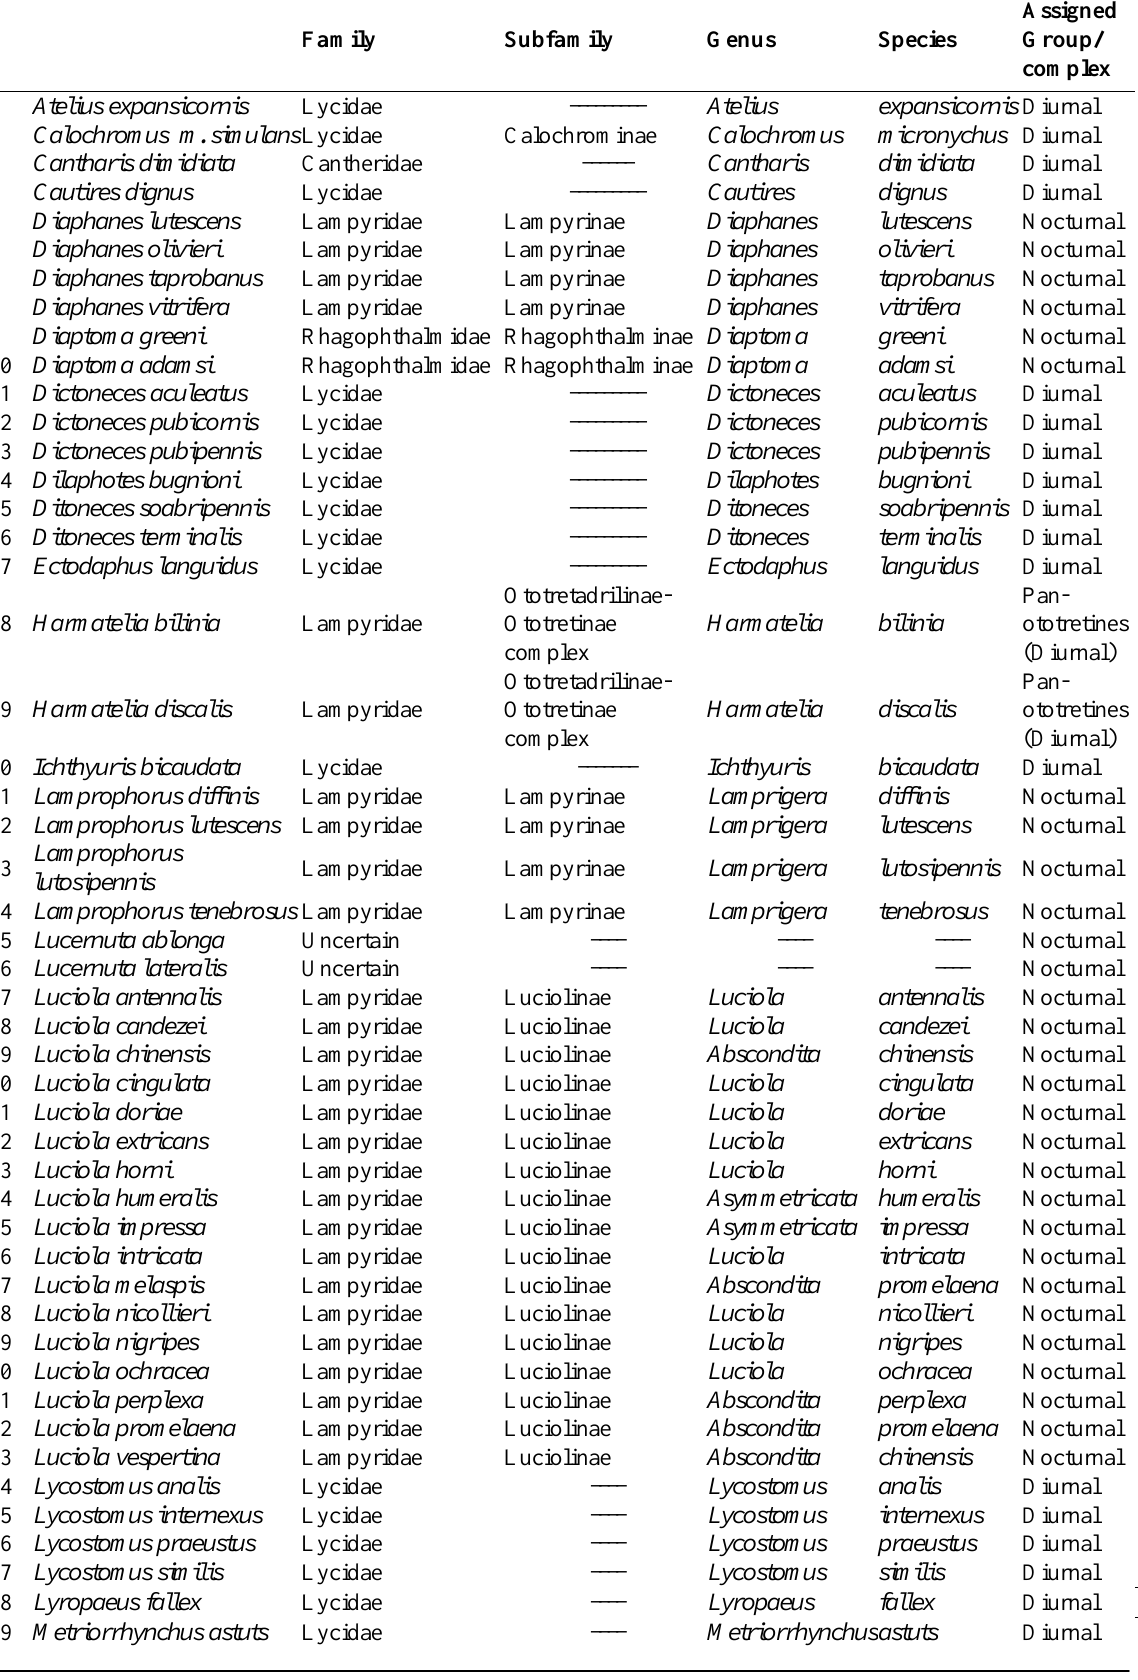
Table 1: Annotated list of Canthoroidea deposited at the Department of National Museums, Colombo and their revised classification according to the updated systematics in South-east